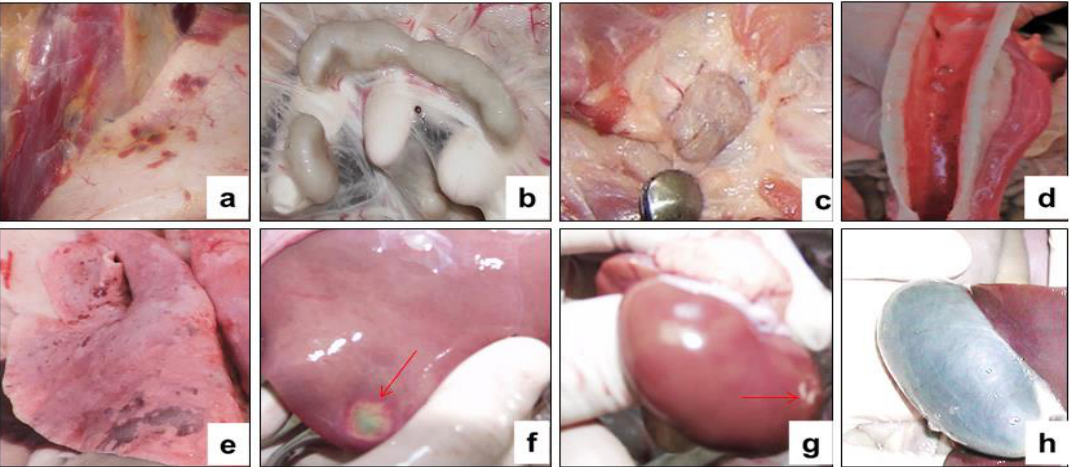
Figure 10. Internal examination of forcibly euthanized sheep post-challenge with the virulent strain A of the SPPV. ( a ) Spotty hemorrhages in the subcutaneous tissue and musculature. ( b ) Enlarged mesenteric lymph nodes. ( c ) Enlargement of the popliteal lymph nodes. ( d ) Subcapsular lesions in the tracheal mucosa. ( e ) Spotty hemorrhages, and lesions in the lungs. ( f ) Serous lesion in the liver. ( g ) Subcapsular lesion in the kidney. ( h ) The gallbladder is full.